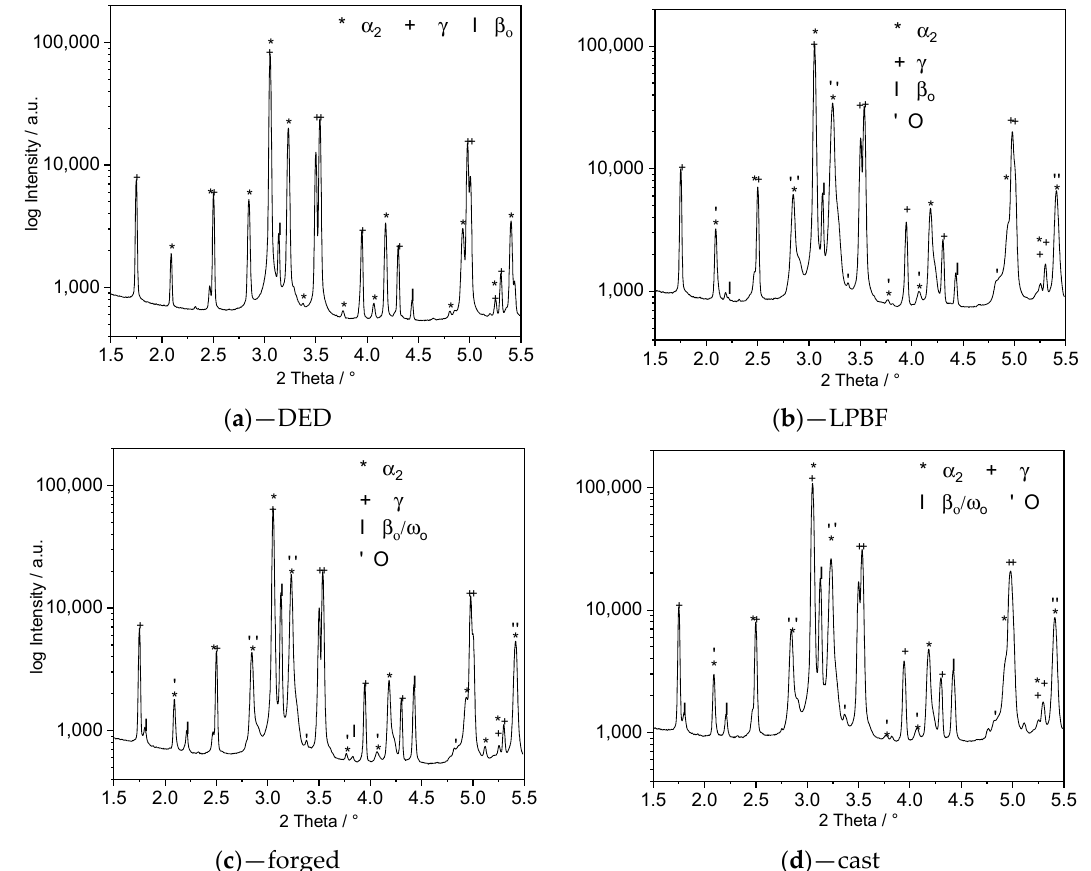
Figure 2. Diffraction patterns of heat-treated TNM ( a ) manufactured by DED; ( b ) manufactured by LPBF; ( c ) manufactured by forging; ( d ) manufactured by casting.